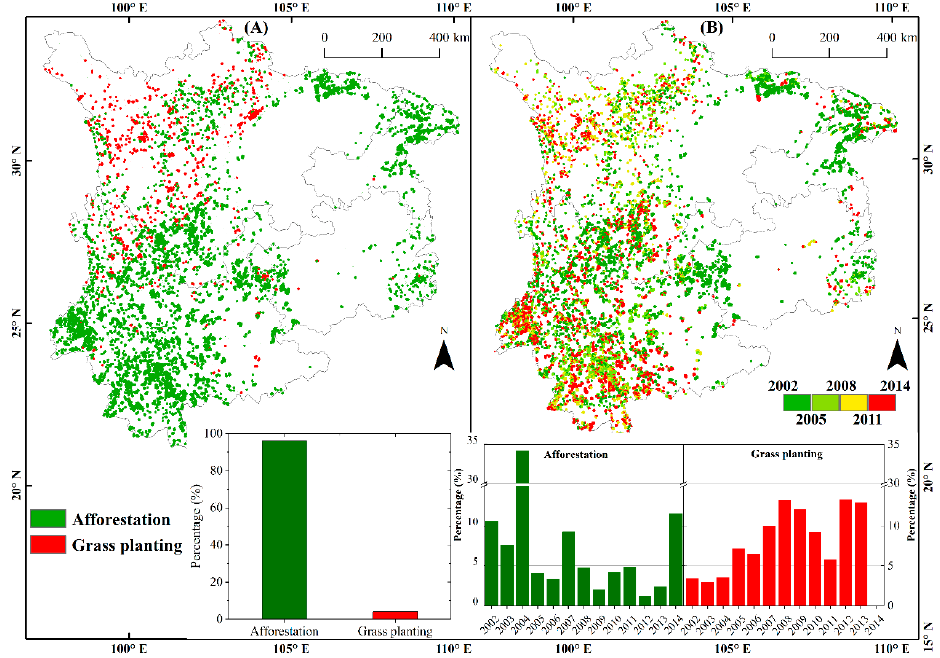
Figure 5. ( A ) Spatial distributions of annual afforestation and grass planting in 2002–2015 and ( B ) their implementation time.